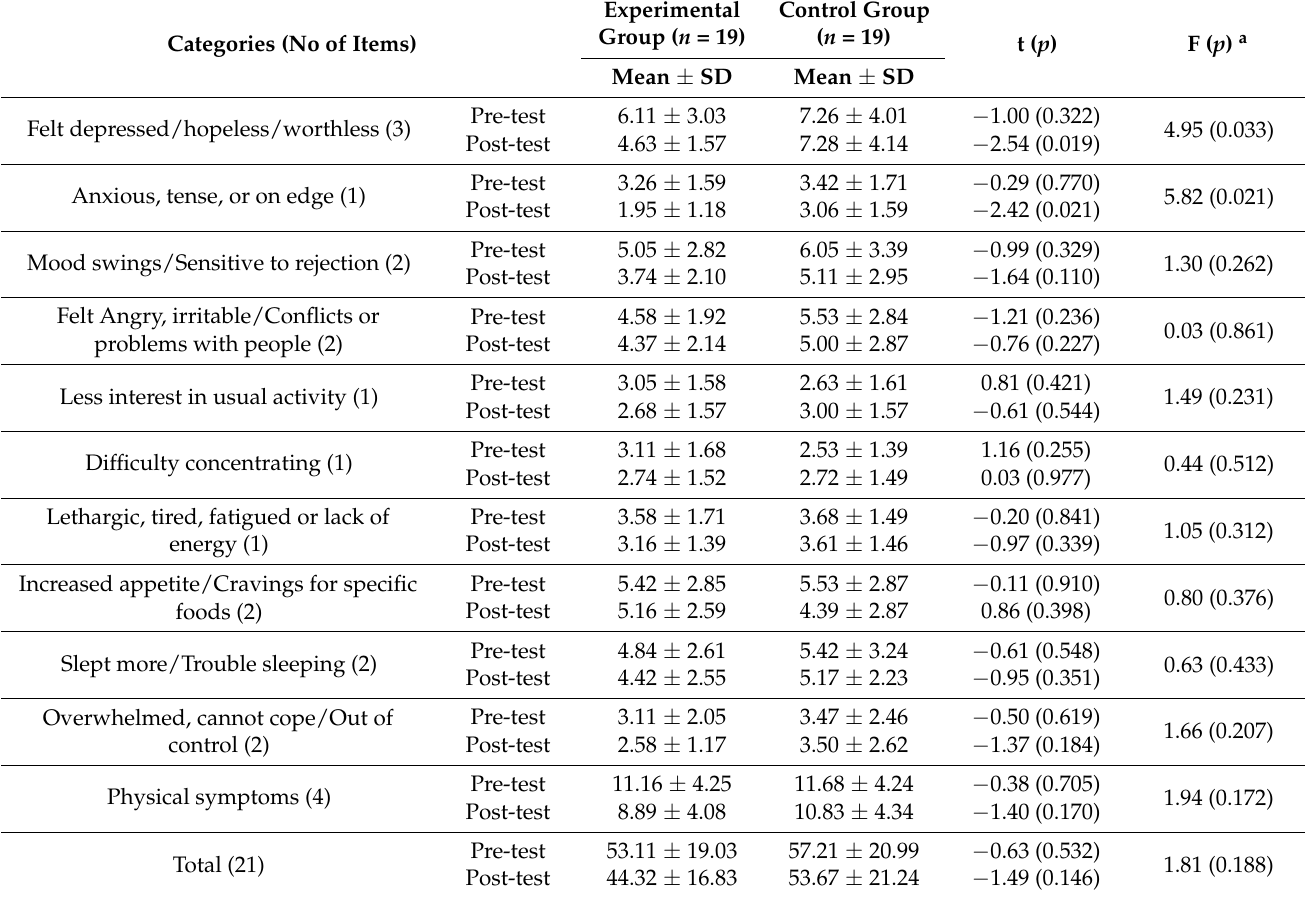
Table 3. Comparison of premenstrual symptoms in the experimental and control groups ( n =